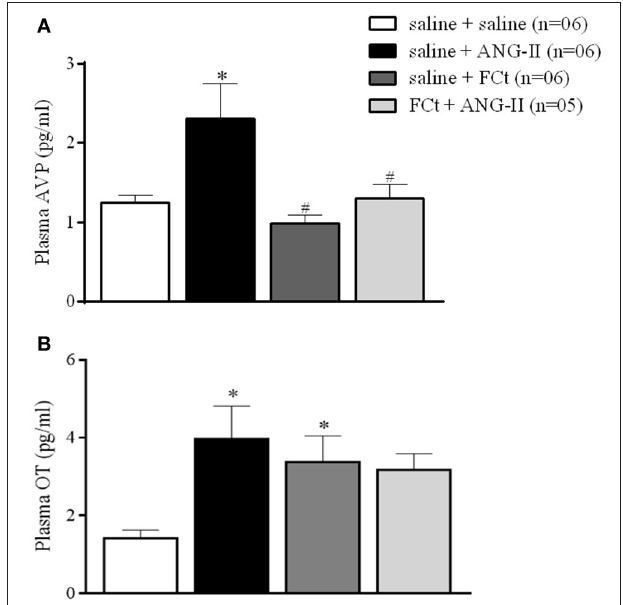
FIGURE 3 | Effect of icv saline, ANG-II or FCt microinjections on water (A) and sodium [1.5% NaCl (B) intake] 5, 15, 30, 60, 120, and 240min after saline or FCt pretreatment in awake rats. Differences among groups were calculated by Two-Way ANOVA followed by the Newman–Keuls post test. Values were expressed as means ± SEM. * p < 0.05 vs. control group (saline + saline). # p < 0.05 vs. saline + ANG-II